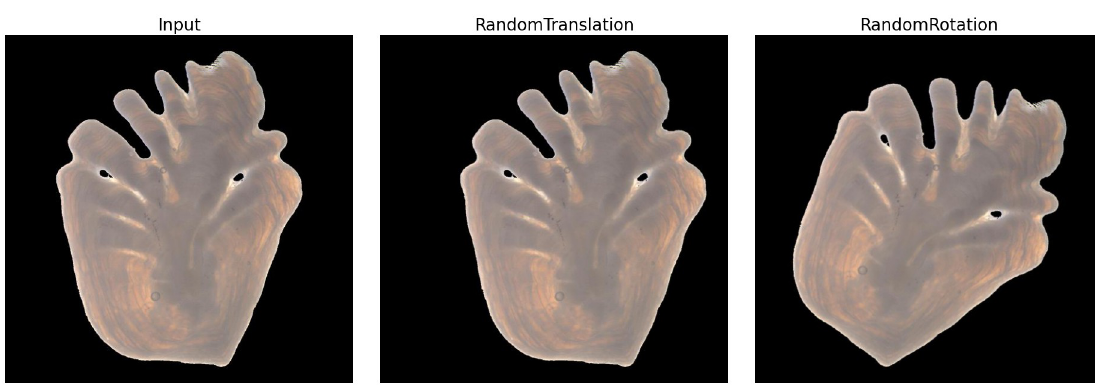
Fig 6. Data augmentation. Random translation and rotation applied on an otolith